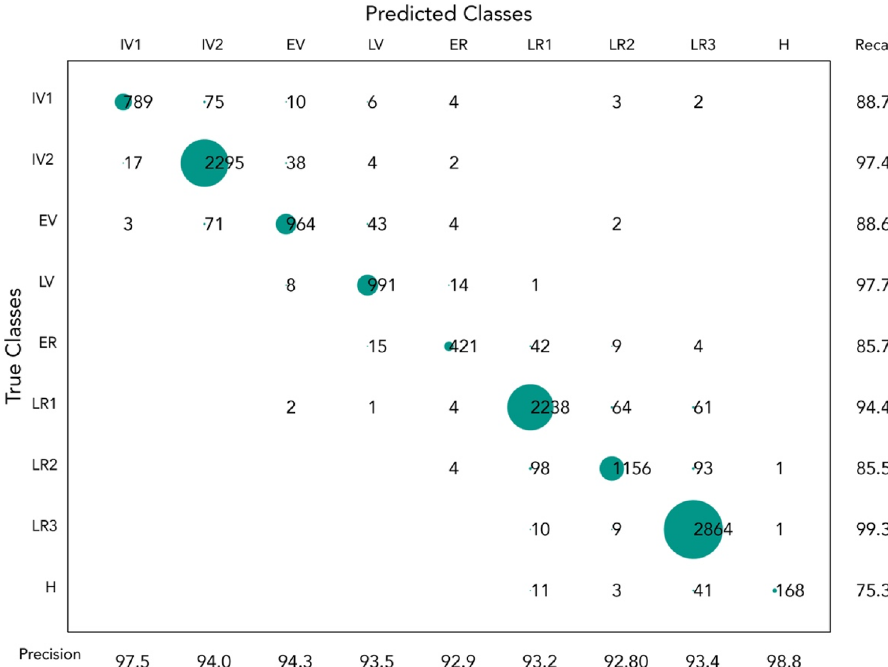
Figure 3. For the years 2013 to 2018, a classification matrix was created that included all classified elements, their magnitude, as well as precision and recall scores. The true classes are on the Y axe, while the model’s predictions are on the X axe. The number of fields classified is represented visually by the size of the bubbles; the numbers along the main diagonal represent those successfully classified.